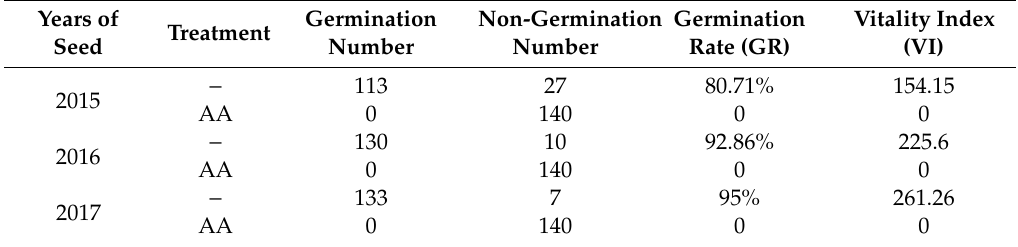
Table 1. Germination rate and vitality index of all sets of seeds as determined by germination test.